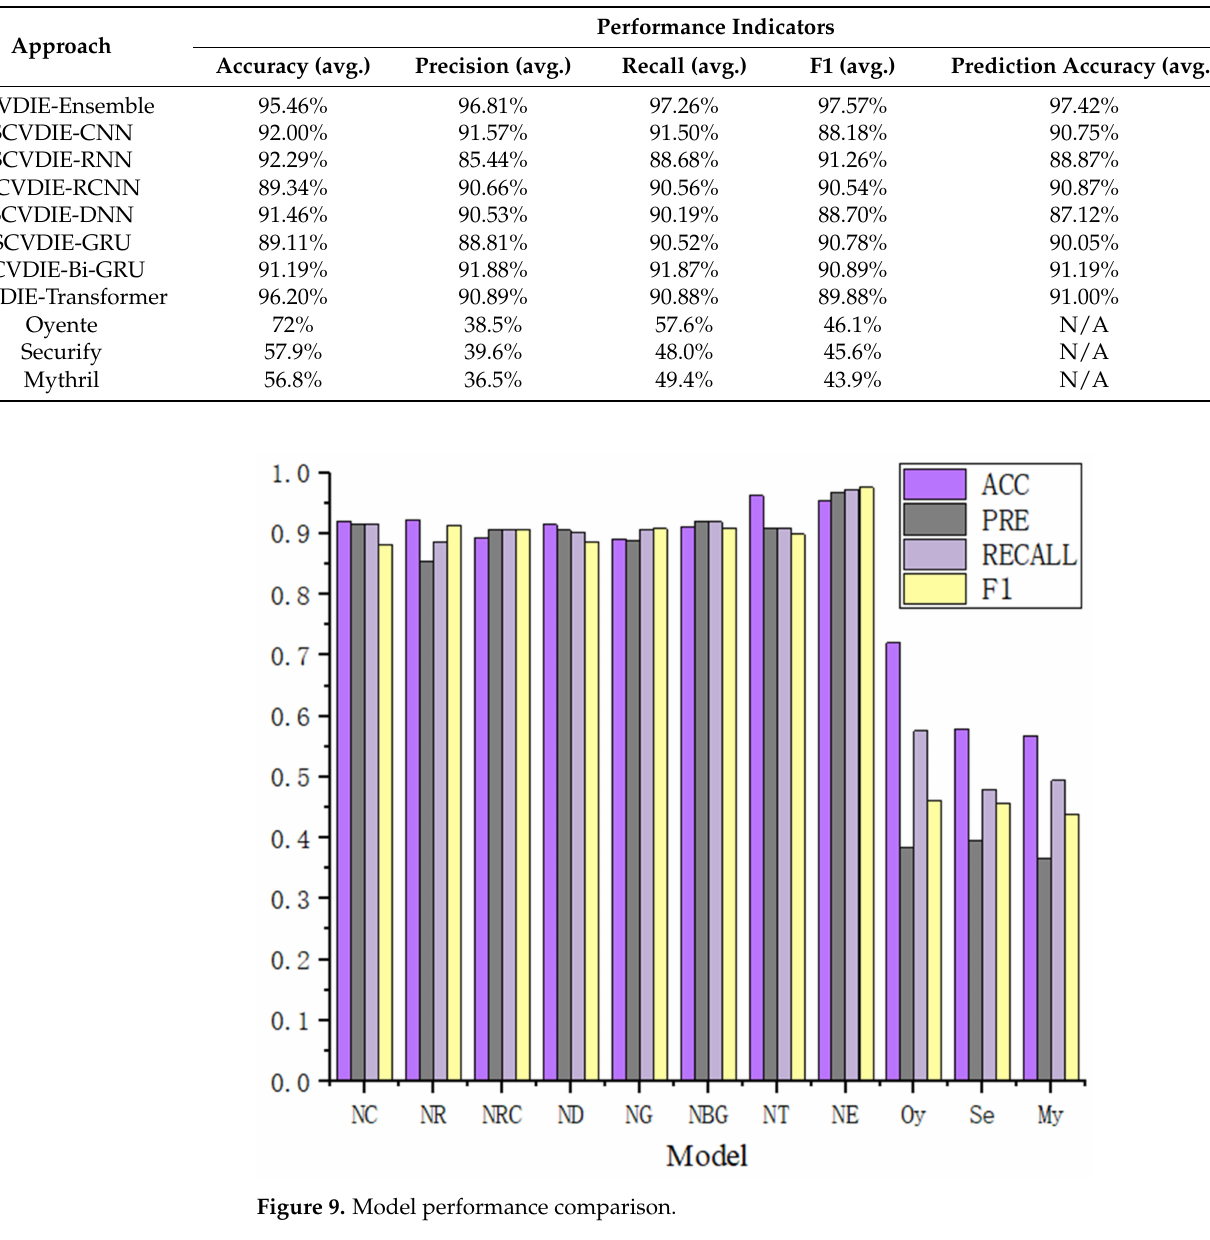
Table 6. Performance evaluation.